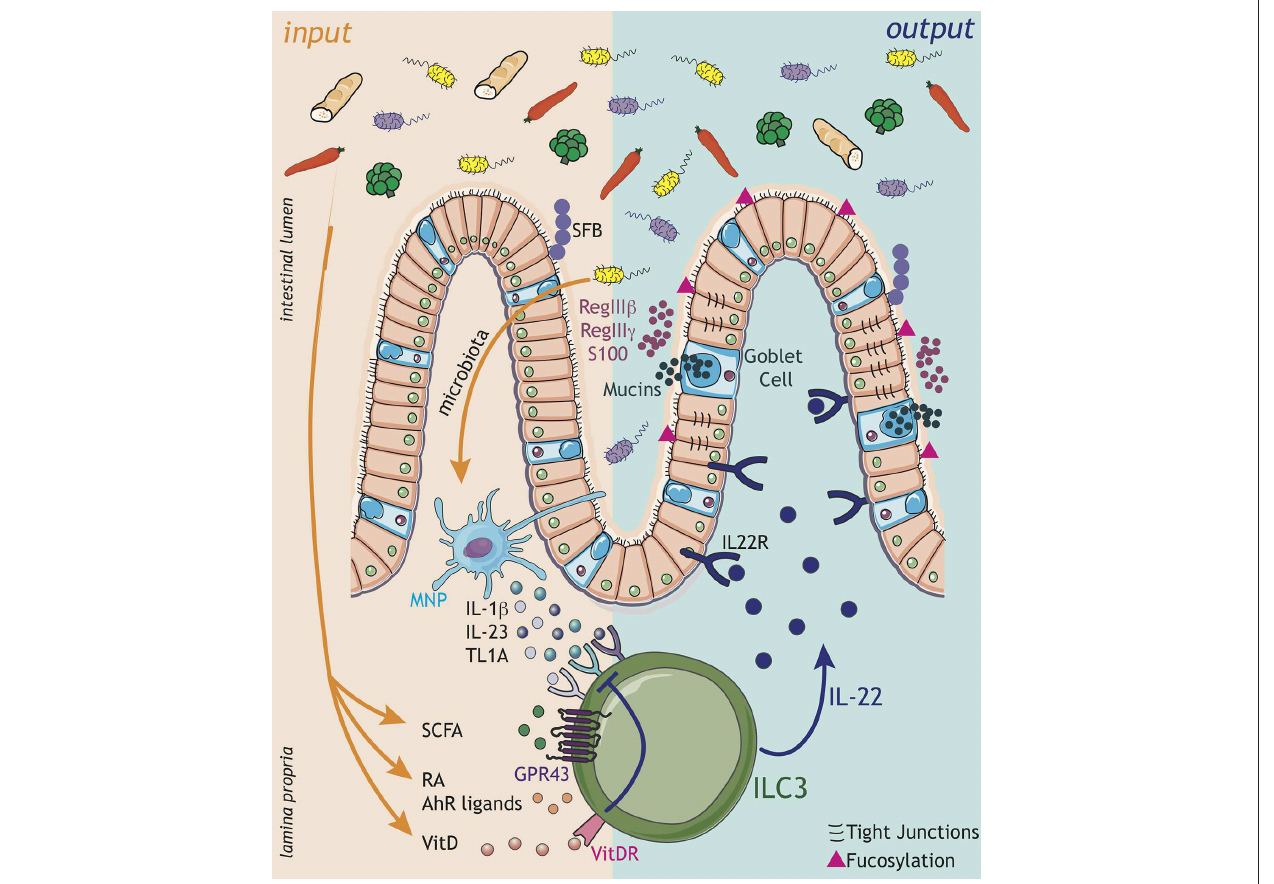
FIGURE 1 | ILC3 engage in complex sensory circuits in order to integrate microbial and dietary cues and enforce mucosal homeostasis. Inputs (orange arrows): ILC3s act as innate immune sentinels of the gastrointestinal tract, and respond rapidly to changes in the tissue environment. Environmental signals, comprising microbial and dietary cues, are sensed either via myeloid cell intermediaries [e.g., dendritic cells (DC), macrophages, also known as mononuclear phagocytes (MNP)], which release cytokine cues (IL-1 β , IL-23, TL1A) to modulate ILC3 function, or through direct sensing of metabolites and dietary ligands. Microbial metabolites, such as short chain fatty acids (SCFA), signal directly to modulate ILC3 function though the receptor GPR43. Additionally, ILC3 integrate dietary cues in the form of the vitamin A metabolite retinoic acid (RA) and AhR ligands, which together promote ILC3 development and effector cytokine responses. In contrast, vitamin D acts as a negative regulator of ILC3 activation by suppressing the ability of ILC3 to sense myeloid cues—such as IL-23. Within the complex tissue microenvironment ILC3 are likely exposed to multiple signals in parallel, which must be appropriately integrated to maintain intestinal homeostasis. Outputs (dark blue arrows): Signals translated by ILC3 are propagated in the form of ILC3-derived outputs —most notably cytokine signals, which are received by other immune and non-immune cells within the local environment. In particular, ILC3-derived IL-22 acts on epithelial cells to enforce intestinal barrier integrity and induce the production of antimicrobial peptides (AMPs) such as RegIII β , RegIII γ , and S100 family proteins, secretion of mucins by goblet cells, modulation of tight junctions and epithelial cell fucosylation. IL-22-dependent pathways further regulate the growth of specific commensal bacteria species that are intimately associated with the host, such as segmented